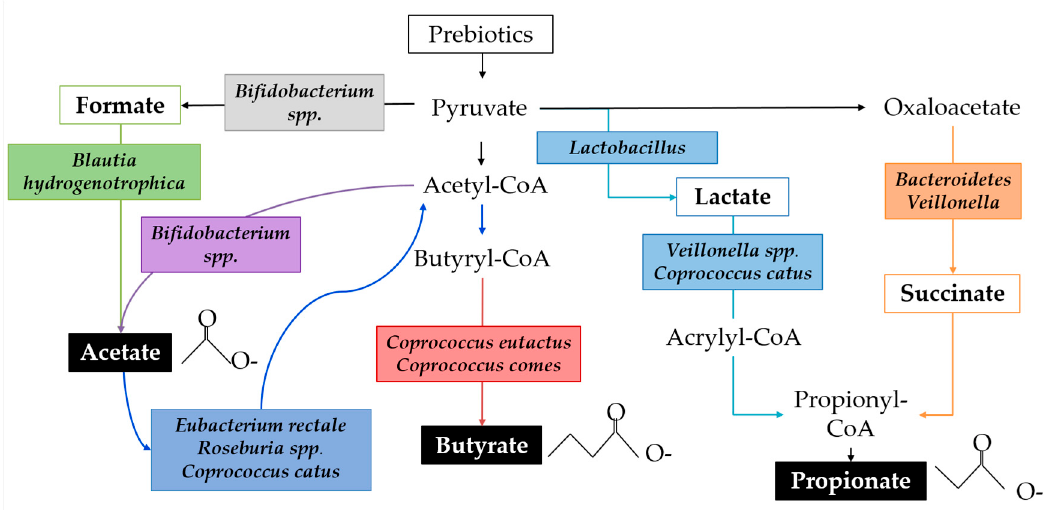
Figure 4. A simplified schematic of the biosynthesis of SCFAs by microbial species identified in human infants. Organic acid metabolites are outlined, and SCFAs are highlighted in black boxes. Species of bacteria found in the infant gut microbiome that are implicated in the corresponding pathway are italicised.